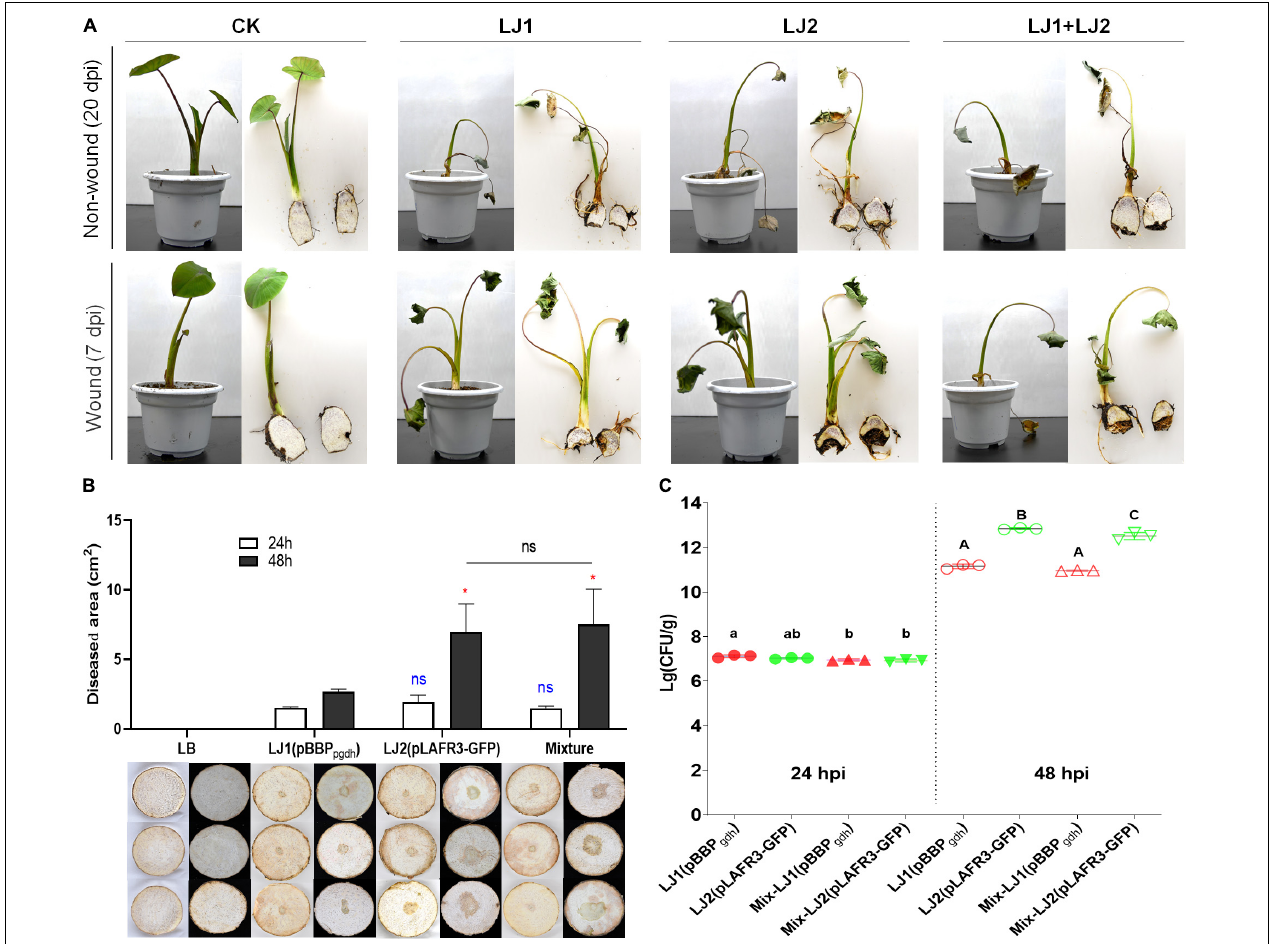
FIGURE 2 | Pathogenicity tests of strains LJ1 and LJ2 on taro. (A) Non-wound (irrigation) and wound (injection) inoculation of strains LJ1 and LJ2 on taro seedlings. For non-wound inoculation, 10 mL of LJ1, LJ2, and LJ1 + LJ2 mixture (OD 600 of 1.2) were, respectively, centrifuged, re-suspended with 50 mL of PBS, and poured into the potted plants. PBS buffer was used as the negative control. The plants were kept in a greenhouse (28 ± 2 ◦ C, 75% ± 15% relative humidity, and 12 h alternating light and dark cycles) and watered once a day with sterile water until disease symptoms were observed. For wound inoculation, 100 µ L of LJ1, LJ2, and LJ1 + LJ2 mixture (OD 600 of 1.2) were, respectively, injected into the taro seedling tuberous roots. LB medium was used as a negative control. (B) Symptoms of taro soft rot after 24 and 48 h post-inoculation (hpi) with LB, strain LJ1, strain LJ2, and LJ1 + LJ2 mixture, respectively. Strains LJ1 and LJ2 were first, respectively, visualized by introducing fluorescence plasmids pBBP gdh (pmCherry) (Liao et al., 2018) and pLAFR3-GFP (pGFP) (Shi et al., 2019), and then 10 µ L of bacterial cultures (grown in LB medium till OD 600 of 1.5) of LJ1(pBBP gdh ), LJ2(pLAFR3-GFP), and LJ1(pBBP gdh ) + LJ2(pLAFR3-GFP) mixture were, respectively, spotted onto taro slices. LB medium was spotted as the negative control. The slices were placed on Petri dishes, sealed and kept in a biological incubator as conditions described above and observed. Photos were taken after 24 and 48 h post-inoculation. The experiment was performed in triplicate. GraphPad Prism 8.4.1 was used to perform unpaired two-tailed t -test, and the data of LJ2 and LJ1 + LJ2 were compared with those of strain LJ1 at corresponding post-inoculation time (blue for 24 h, red for 48 h). Data of LJ1 + LJ2 were also compared with those of LJ2 (black). The data present the means of three replicates and error bars represent the standard deviation. "ns" indicates not significant, * P < 0.05. (C) The colony-forming units (CFU) of LJ1 and LJ2 in taro tissue after 24 and 48 (hpi). After 24 and 48 h of inoculation on taro slices, the diseased tissue was cut off and weighed, and then ground into homogenate with 10 mL of PBS buffer. The homogenate was diluted in series, and 100 µ L of each gradient dilution was spread onto fresh LB agar plates, incubated at 28 ◦ C overnight. Colonies between 30 and 300 in the plates were counted. The experiment was repeated three times in triplicate. Statistical analysis was performed on each group of data and significantly different values (ANOVA P < 0.05) are indicated by different